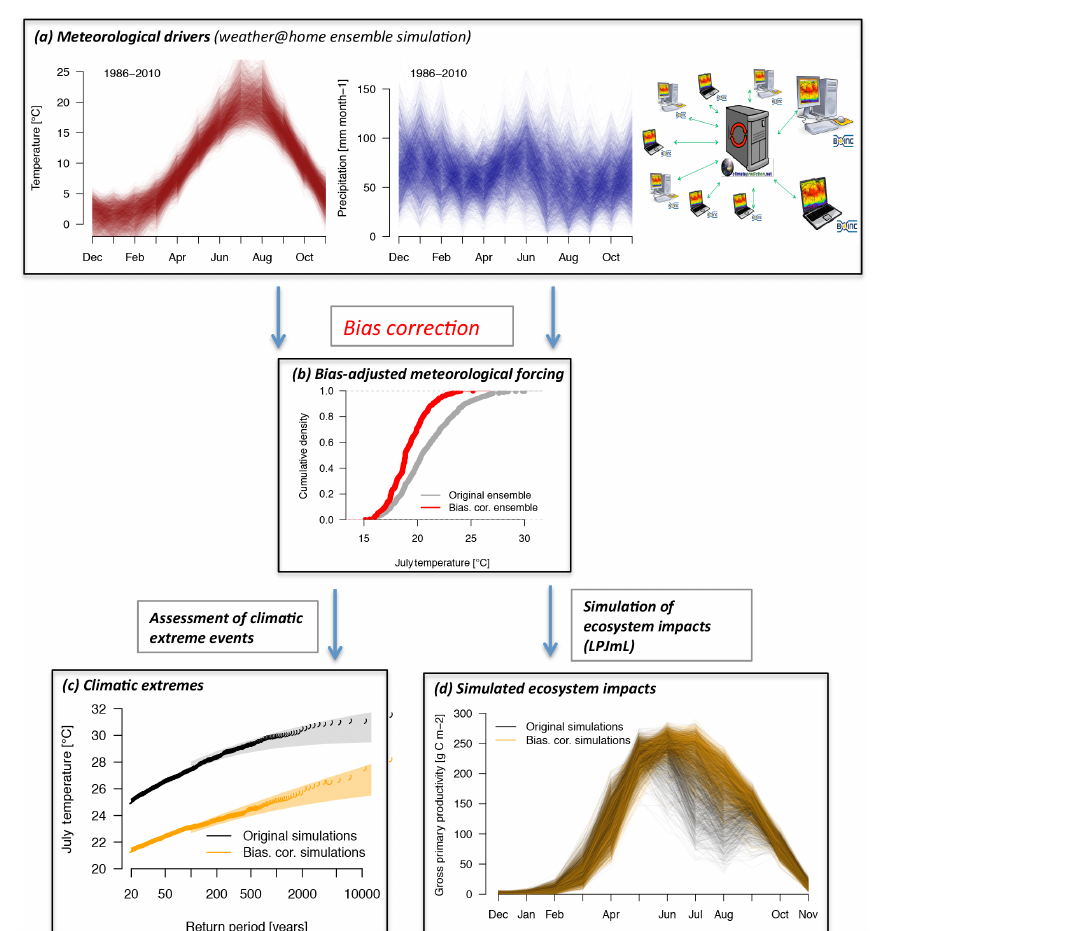
Figure 1. Methodological workflow of the study. (a) Generation of regional climate model simulations using a large ensemble modelling framework (climateprediction.net/weatherathome). (b) Adjustment of biases in the regional climate model’s output. (c) Assessment of weather and climate extreme events. (d) Ensemble simulation of ecosystem–atmosphere fluxes of carbon and water using the LPJmL